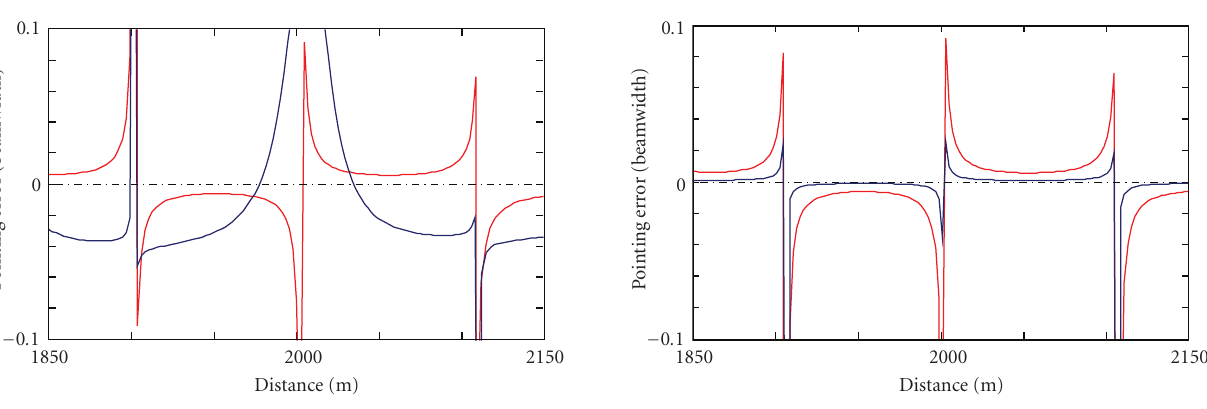
Figure 14: Pointing error, in elevation (red) and azimuth (blue) for a crossfeed monopulse with a 10 ◦ inclination around antenna boresight direction (roll or pitch). A 2 ◦ phase error on the elevation secondary channel is also present.